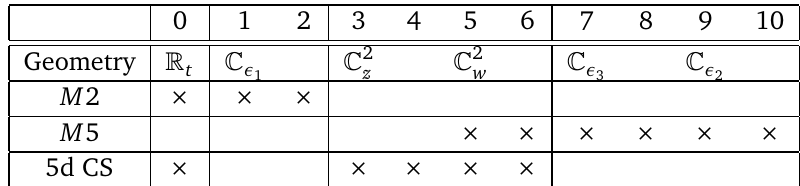
× (cid:67) × (cid:67) , where ε ε z or w i j